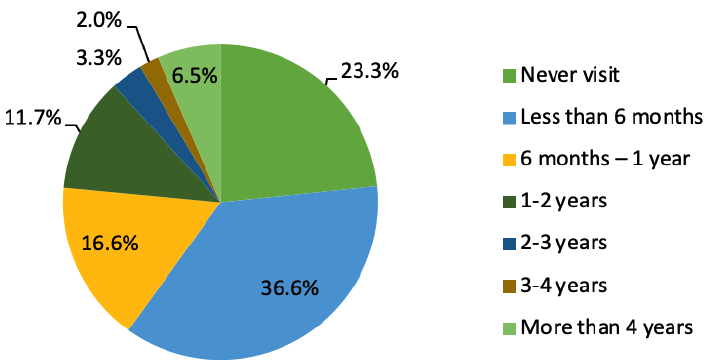
Figure 3. Participant dental visits.